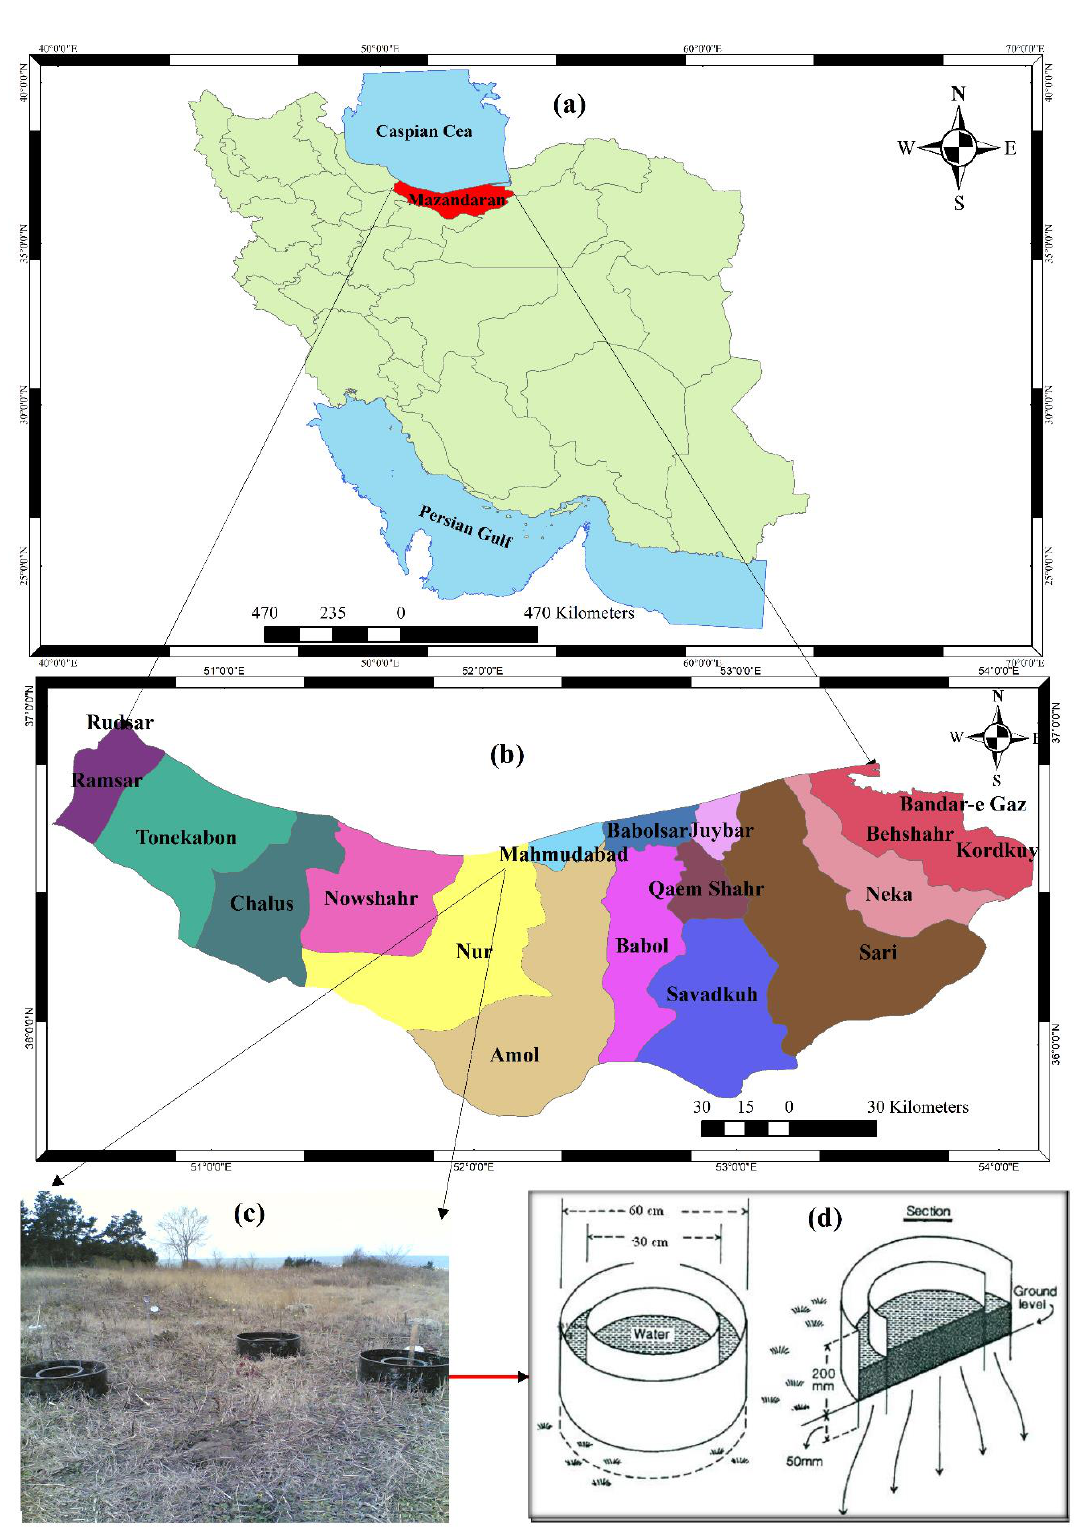
Figure 1. Geographical position of the application site on Iran ( a ) and Mazandaran province ( b ) maps accompanied with a close-up view of the site where the double-rings infiltrometers were installed ( c ) as well as a cross-section of a double-rings infiltrometer adapted from Diamond and Shanley [35] ( d ).